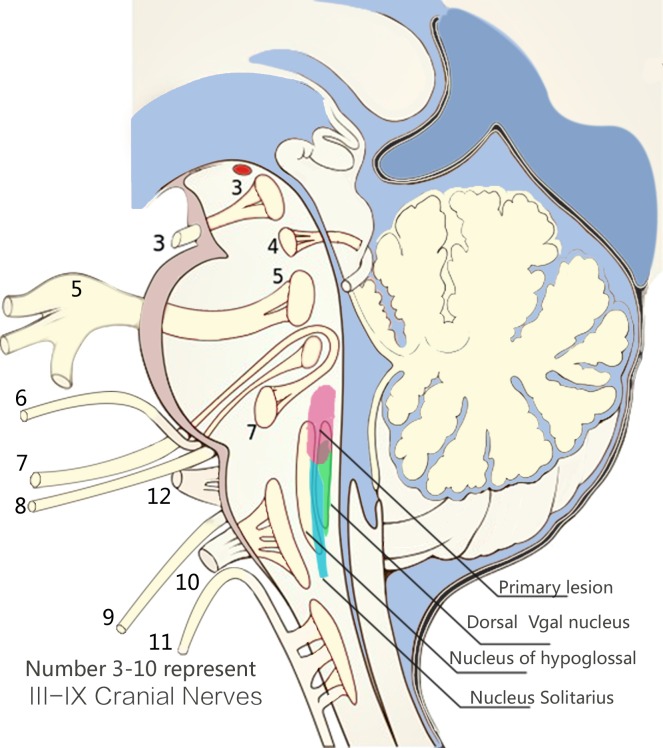
Loctation of primary lesion.The diagram showed the location of primary lesion of brainstem encephalitis induced by EV71, which was a longitudinal lesion at the posterior junction region of the pons and medulla oblongata.